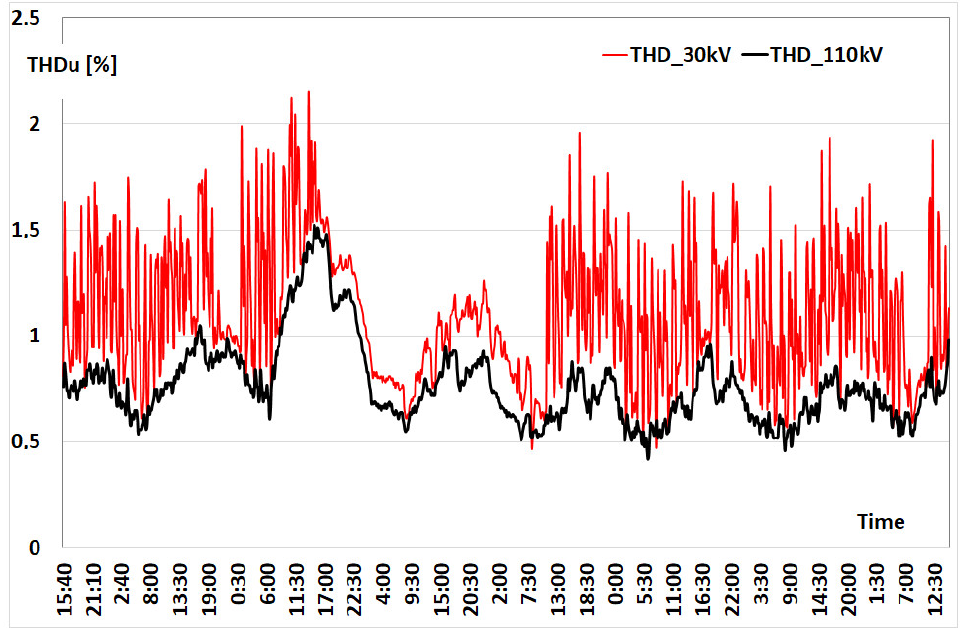
Figure 6. Harmonic distortion changes THD U recorded during the measurement week in the steel plant supply network and the arc furnace supply line.